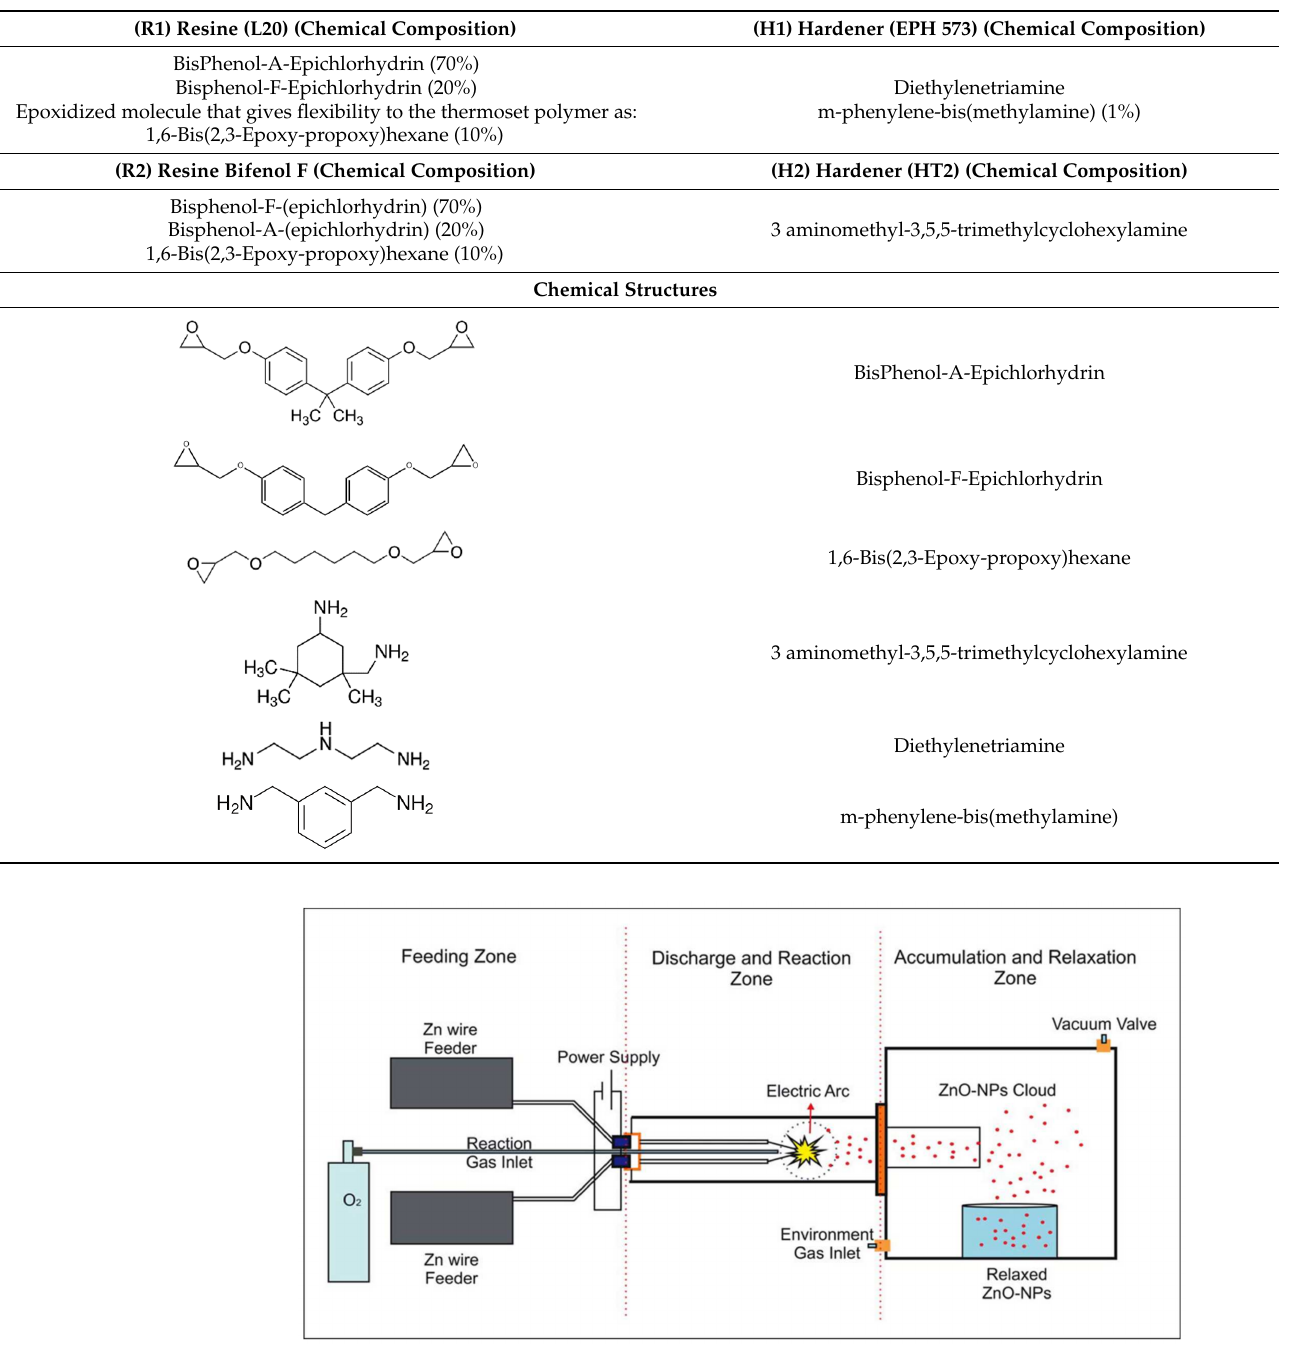
Figure 1. Schematic of equipment based on controlled atmosphere arc discharge (DARC-AC1), used for ZnO nanoparticle synthesis, without passivated